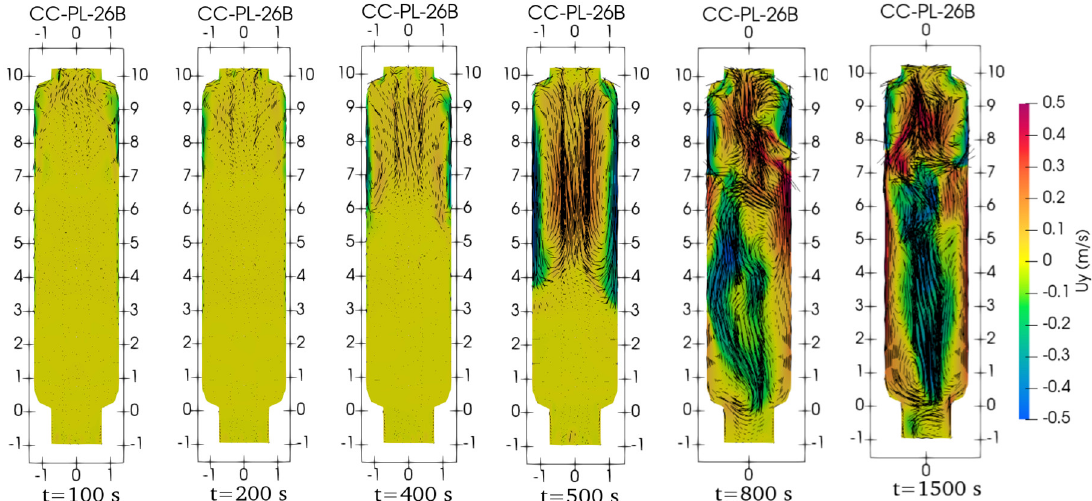
Figure 16. The predicted of the vertical velocity ( Uy ) by means of the SST k- ω turbulence model with CHT.